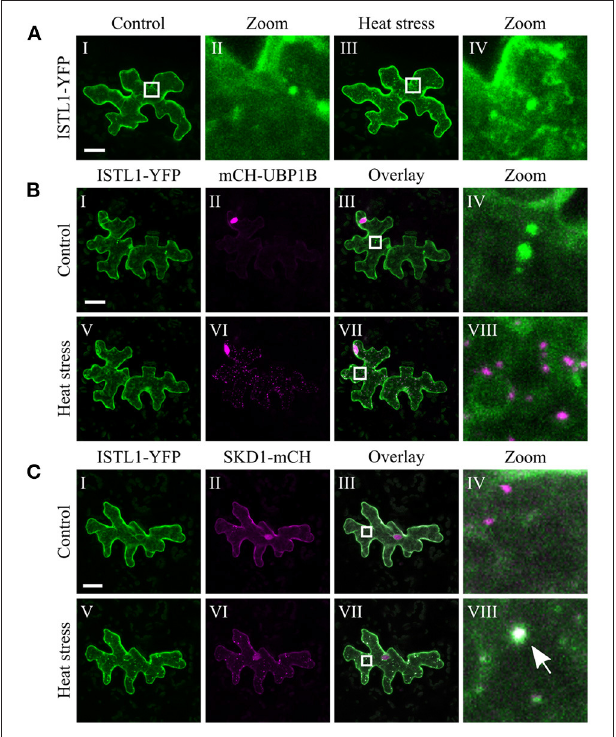
FIGURE 9 | Subcellular localization of ISTL1 before and after heat stress. Representative images of CLSM stacks (maximum projections) of leaf epidermal cells single or double transformed with constructs overexpressing ( 35S promoter) ISTL1. The results are summarized in Table 3 . The same cells were imaged before and after heat stress. Co-localizing structures are indicated by arrow heads. Scale bar = 20 µ m. ISTL1-YFP (A) alone, (B) with mCH-UBP1B, (C) with